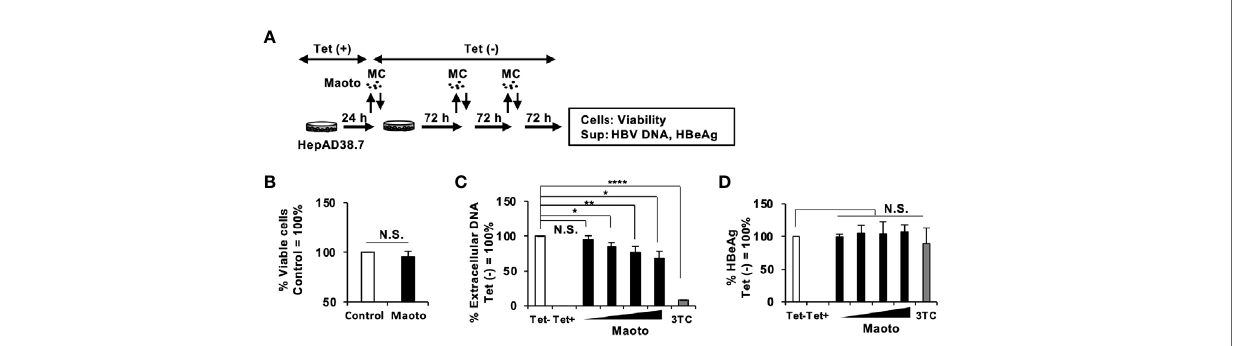
FIGURE 2 | Maoto dose-dependently inhibits hepatitis B virus (HBV) production in HepAD38.7 cells. (A) Schematic representation of the protocol of maoto treatment in HepAD38.7 cells. Cells were treated with distilled water (control) or concentrations of 1.5625, 6.25, 25, and 100 µg/ml of maoto extract in the culture medium without tetracycline (Tet(-)) to induce hepatitis B virus (HBV production. The cells were incubated for 9 days with refreshing the medium and Kampo (MC) every 3 days. (B) Cell viability in HepAD38.7 cells. Cells were treated with 100 µg/ml maoto extract for 9 days. Viability was determined after 9 days of treatment using the CellTiter-Glo assay. (C) Extracellular HBV DNA. HBV DNA in culture supernatants of HepAD38.7 cells was measured by real-time PCR. (D) Extracellular HBeAg. HBeAg in culture supernatants of HepAD38.7 cells was determined by enzyme-linked immunosorbent assay (ELISA). Lamivudine (1 µM, 3TC) was used as a positive control for the inhibition of HBV production. Values are expressed as the mean percentage + S.E. of three independent experiments. * P < 0.05; ** P < 0.01; **** P < 0.001; N.S., no signi fi